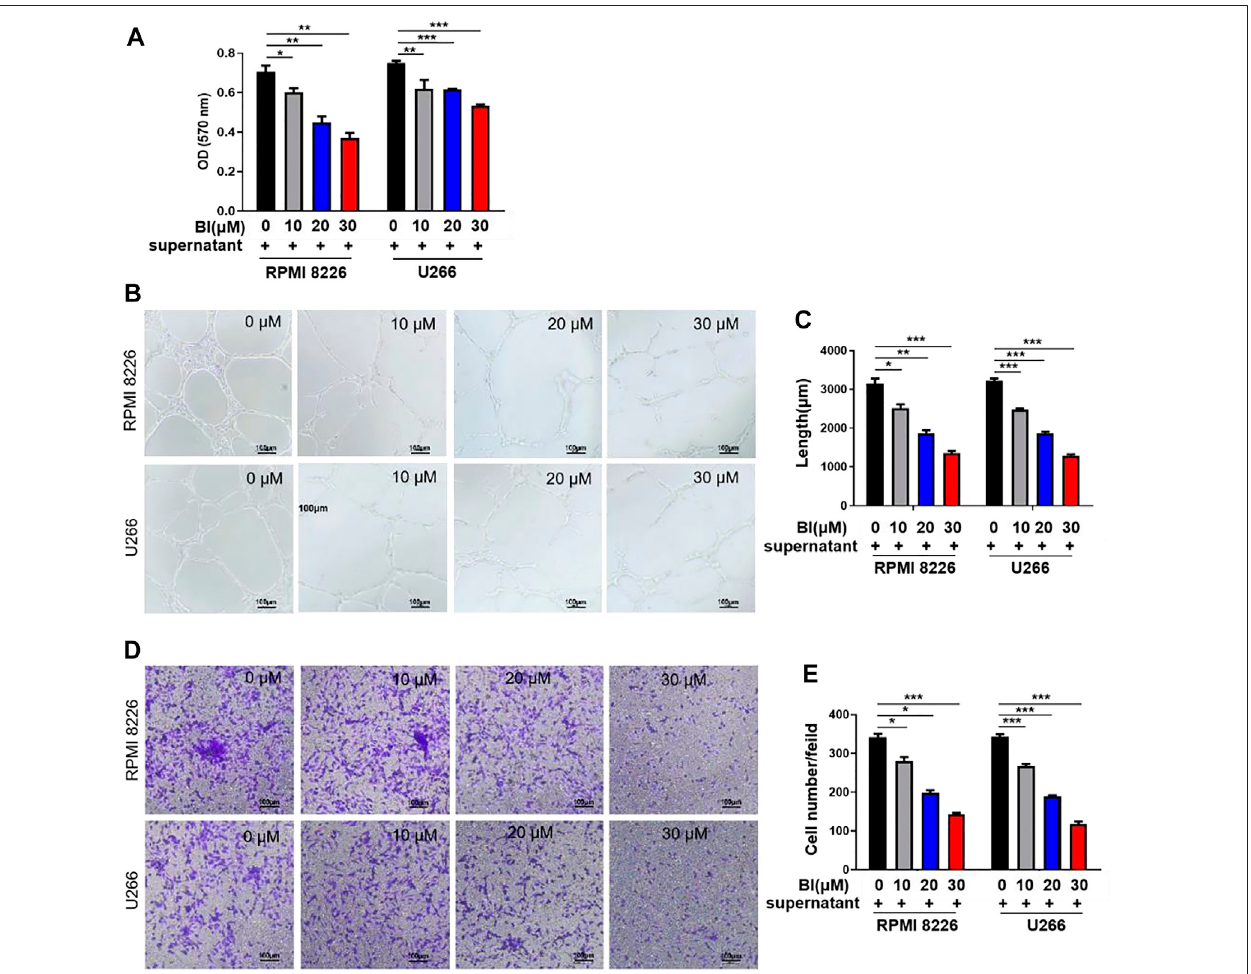
FIGURE1| BaohuosideI(BI)inhibitedmultiplemyeloma(MM) – inducedangiogenesis. (A) BI-treated MMcellsupernatant inhibitstheHUVECs.Thevalueofoptical density (OD) was determined by MTT assay at an absorbance of 570 nm. (B,C) Tube formation experiment was carried out by adding HUVECs and BI-treated MM cell supernatant to the matrix gel. (D,E) HUVEC migration experiment evaluates the migration ability of cells through the transwell chamber.